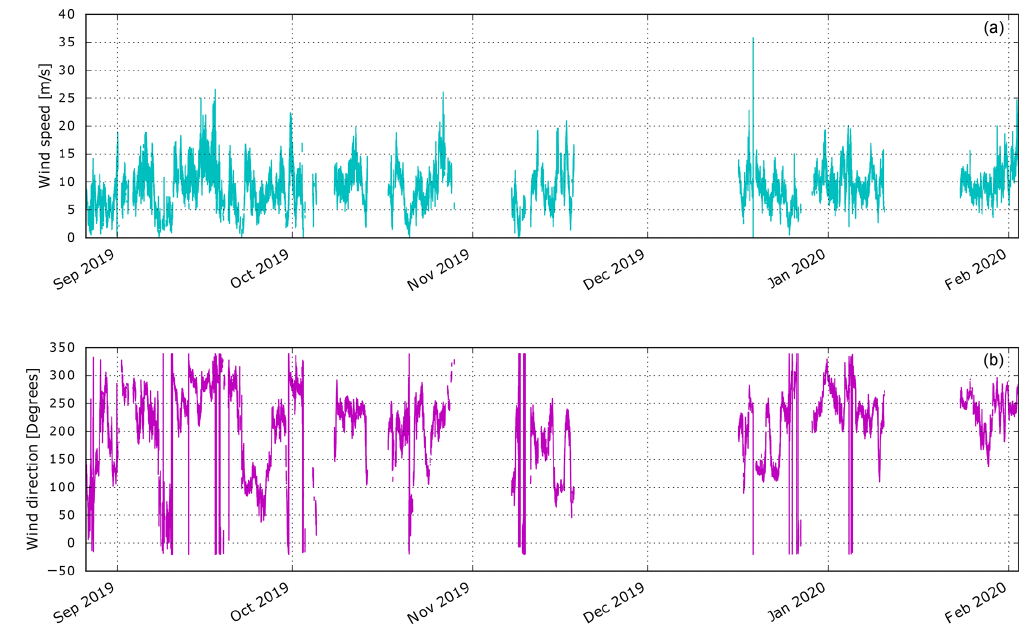
Figure 2. Wind-speed (a) and direction (b) measurements at hub height of 65m processed from the inflow lidar mounted on turbine B08. Missing data correspond to equipment downtime and filtering of low signal quality periods.